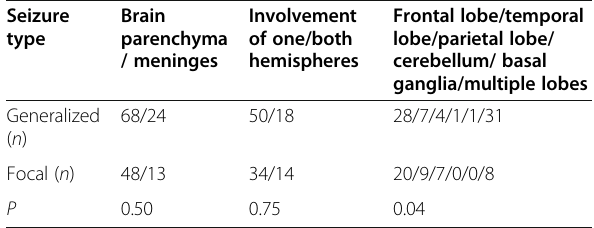
Table 4 Correlations of seizure type with tumor location Seizure Brain type